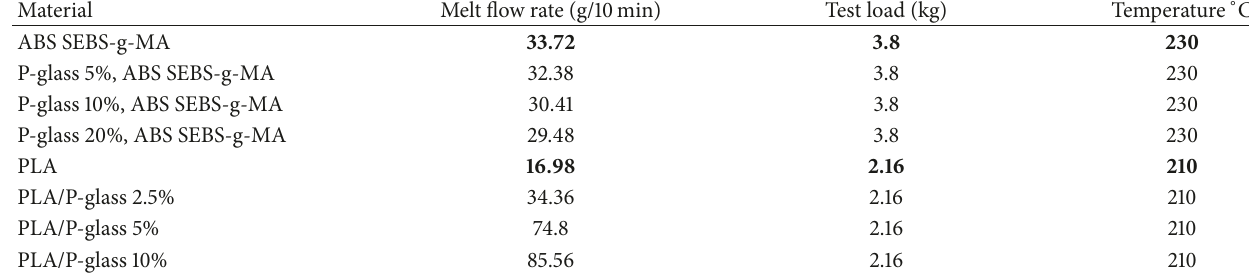
Table 8: Melt flow rate values for the materials tested in this study.